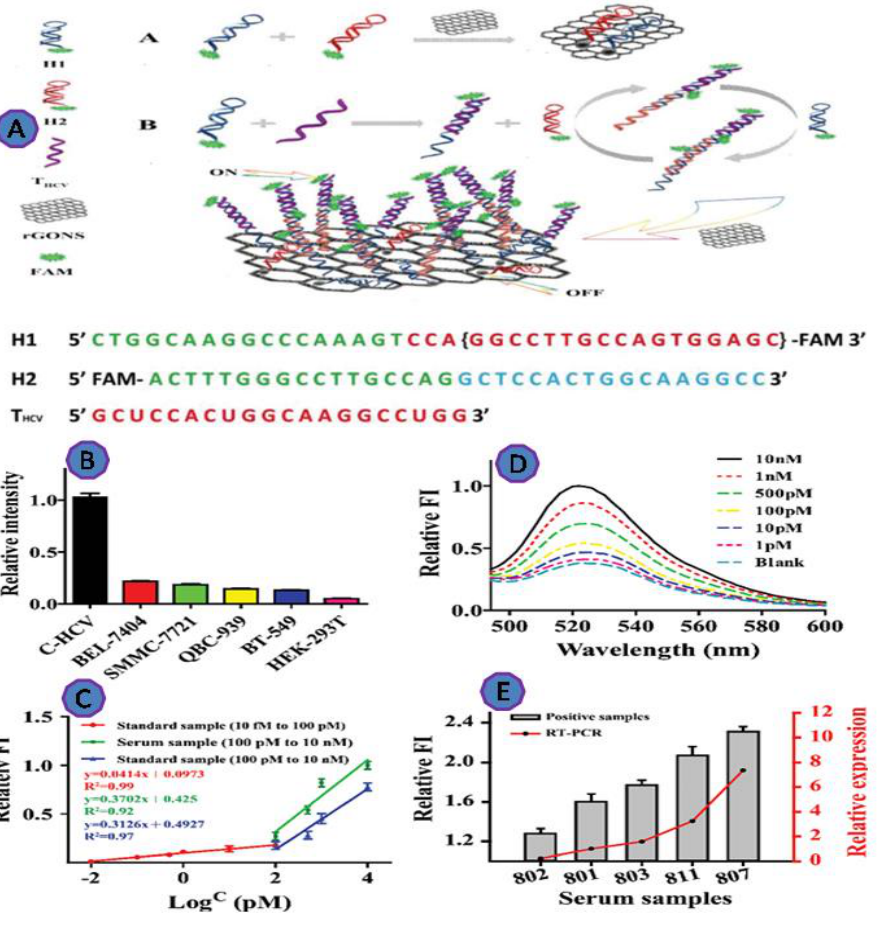
Figure 11. ( A ) Graphic depicting the proposed rGONS-HCR system for HCV detection; ( B ) THCV detection in various cell lysates; ( C ) fluorescence spectra of the rGONS-HCR in the presence of THCV at various concentrations in normal human serum; ( D ) the relative fluorescence intensity (FI) vs. THCV concentration; ( E ) THCV detection in clinical serum samples. Reprinted with permission from Ref. [79]. Copyright 2019, ROYAL SOCIETY OF CHEMISTRY.